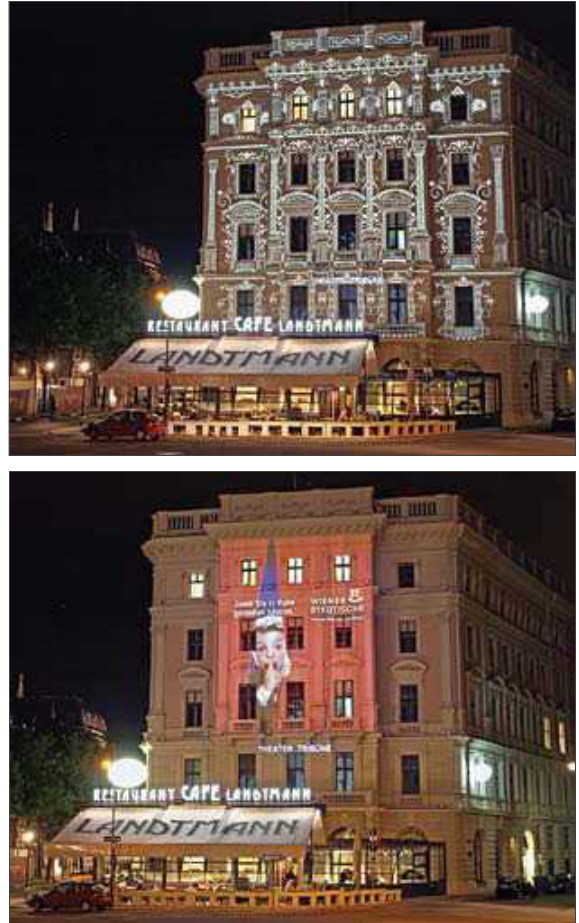
Fig. 13. Media projection on Landtmann building facade in